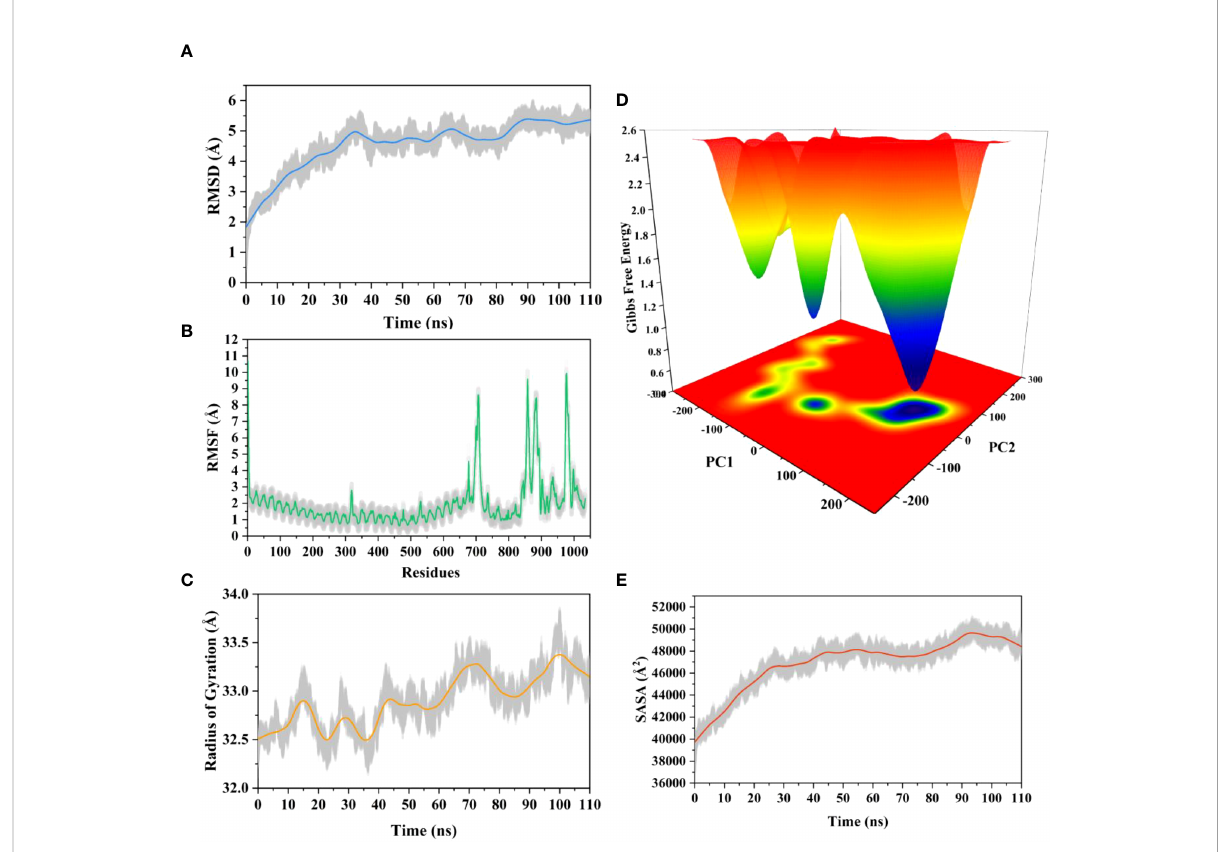
FIGURE 8 Molecular dynamics simulation of Neo-1 and TLR-3 complex at 110ns (A) Root means square deviation (RMSD) plot of the complex, representing mild fl uctuations (B) The Root means square fl uctuation (RMSF) plot of the docked complex (C) The Radius of Gyration plot of the docked complex (D) Free energy landscapes (FELs) of the docked complex. High, intermediate, and low/stable energy states are shown in red, yellow/green, and light-to-dark blue color in the graph, respectively (E) Alterations in Solvent-Accessible Surface Area (SASA) pro fi le of the docked complex during the